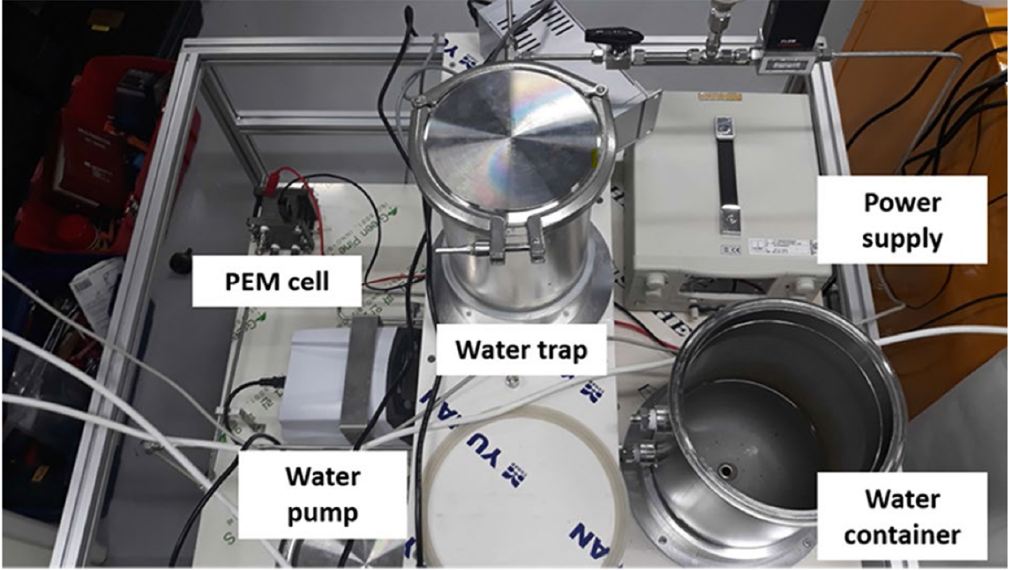
Figure 17. Electrolysis system using the proton exchange membrane (PEM) cell [87].